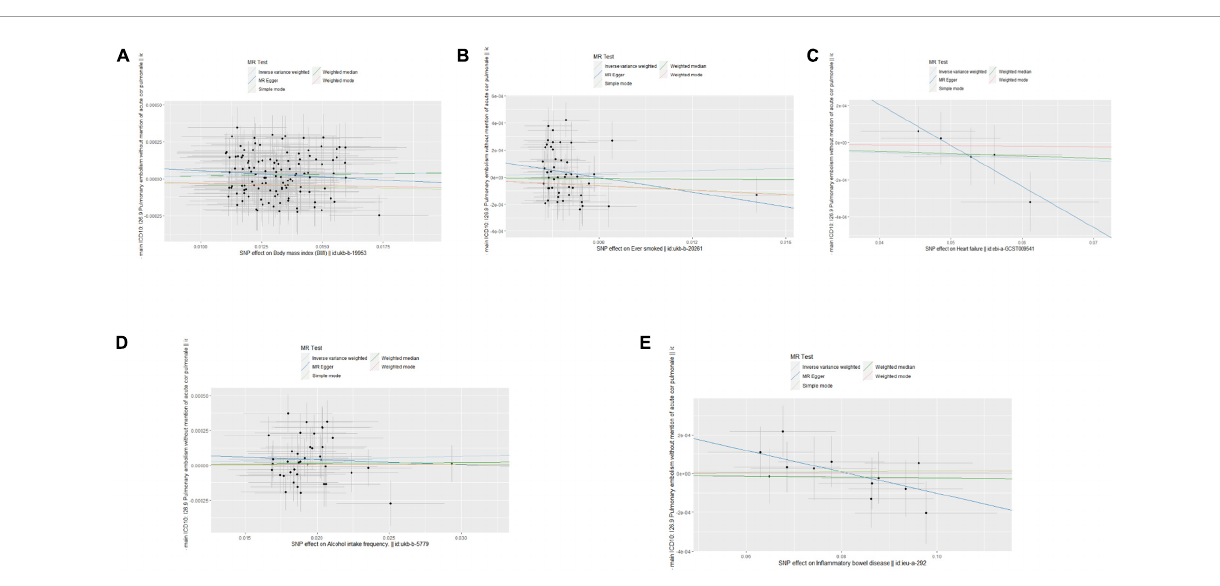
FIGURE4 Scatter plots of the causal effects of body mass index (BMI), ever smoking, heart failure, alcohol intake frequency, and inflammatory bowel disease (IBD)-related single nucleotide polymorphism (SNPs) on pulmonary embolism (PE). The effect sizes of Mendelian randomization (MR) estimates for BMI (A) , ever smoking (B) , heart failure (C) , frequency of alcohol intake (D) , and IBD (E) are